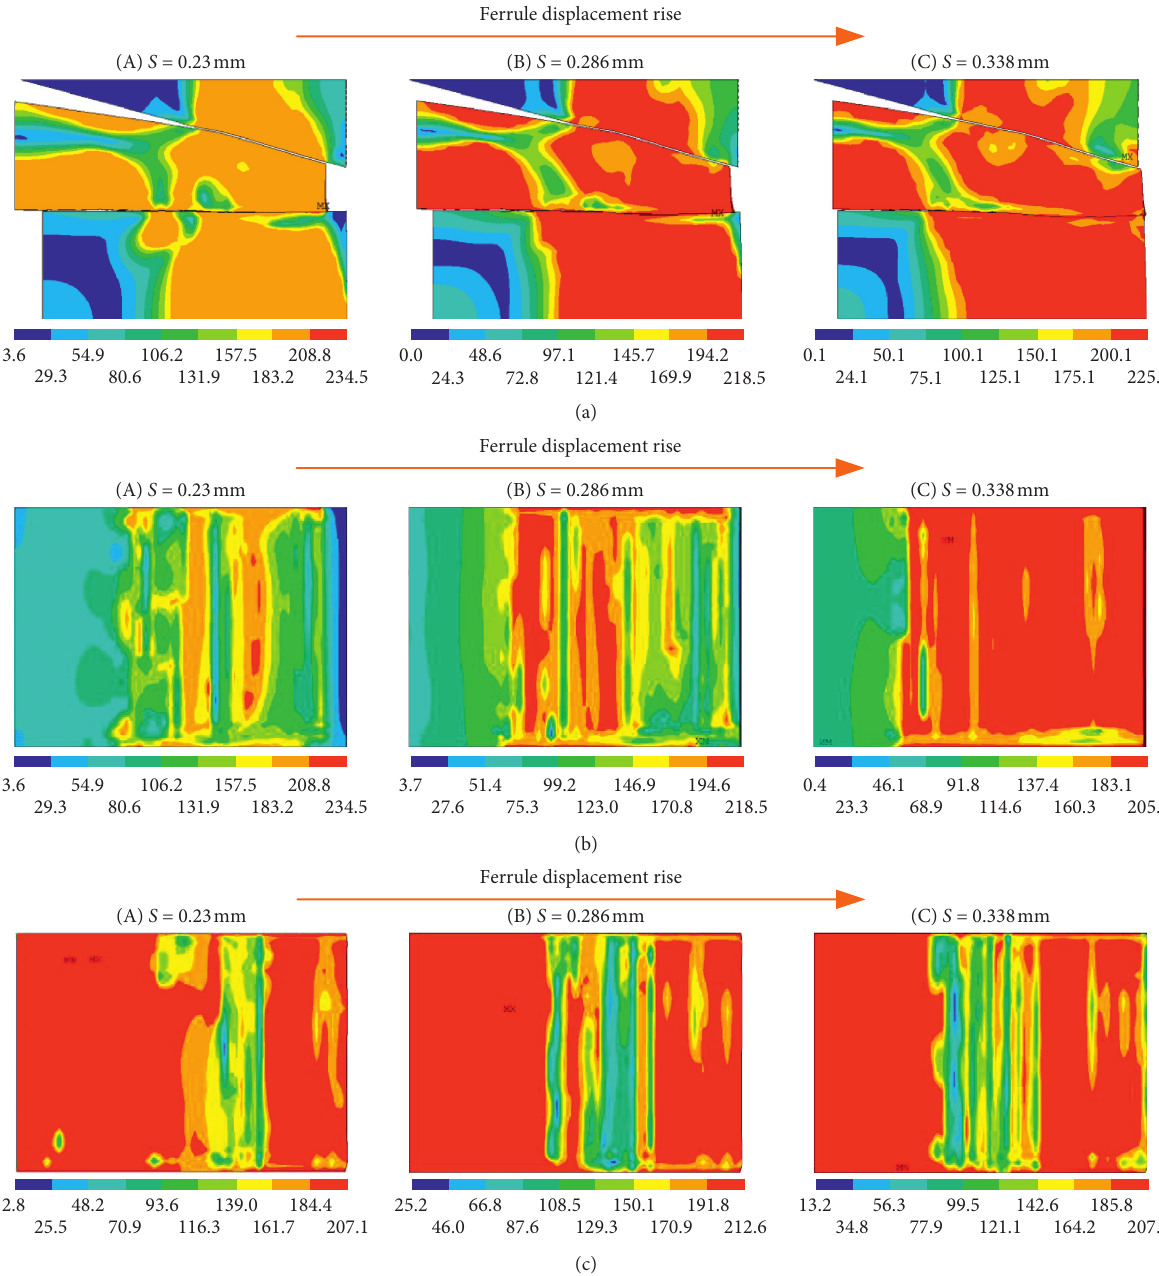
Figure 8: Stress distribution of fittings under different ferrule displacements and the 21 MPa fluid pressure. (a) Seal state of fittings. (b) Stress distribution of pipeline surface. (c) Stress distribution of ferrule